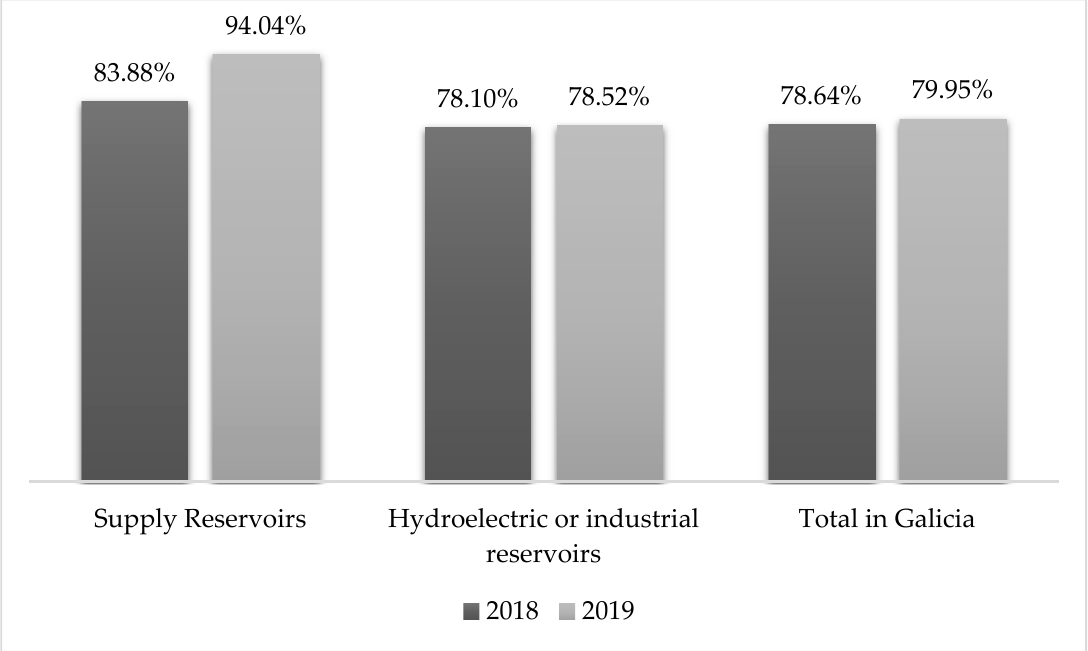
Figure 1. Comparison of the average occupation of the reservoirs in Galicia. Comparison between 2018 and 2019. Source: Hydrological bulletin of Xunta de Galicia [28].